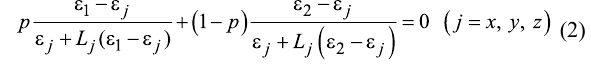
Figure 1: Incidence of the probe beam on the sample and the labora- tory ( x ', y ', z ') and the sample ( x , y , z ) coordinate systems.